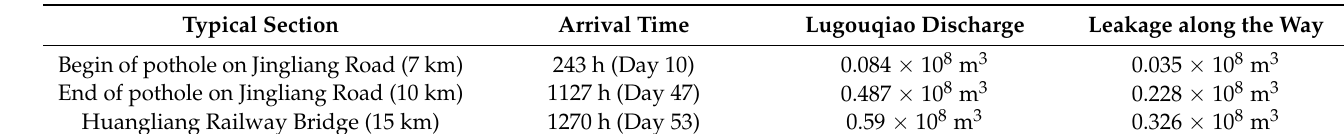
Table 3. The results of the water flow routing process in spring 2019.